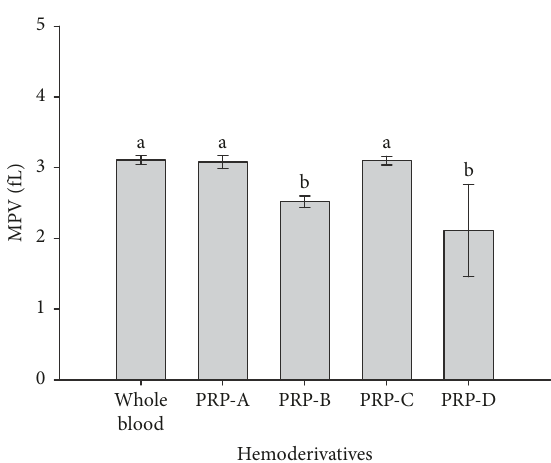
Figure 4: Mean ( ± SD) of mean platelet volume (MPV) (fL) in whole bloodandfourbovinePRPs(A,B,C,andD).a-b:differentlowercase letters denote significant differences by the Tukey test ( 𝑝 = 0.001 ).